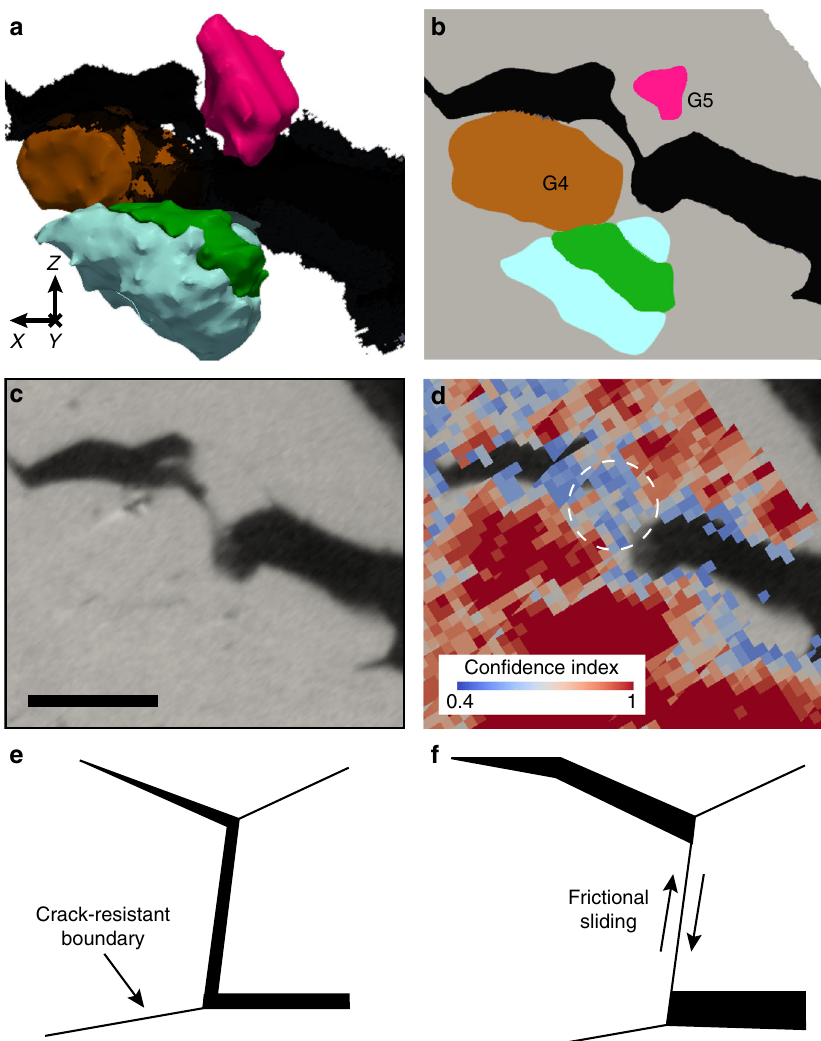
Fig. 5 Frictional sliding. a 3D reconstruction of crack de fl ection event (CDE) #4 and b a 2D cross section showing the grains that undergo frictional sliding. c A 2D section through the corresponding x-ray absorption tomography data showing opposing crack faces in contact in the region around grains 4 and 5. Scale bar: 100 μ m. d Low con fi dence index voxels in the high-energy diffraction microscopy reconstruction in the vicinity of the sliding contact (highlighted by the white circle), indicating severe local plastic deformation. e, f Schematic of frictional sliding mechanism. e A crack is de fl ected past vertical due to a crack-resistant boundary, leading to f the re-impingement of grains from opposing crack faces upon each other followed by sliding along their area of